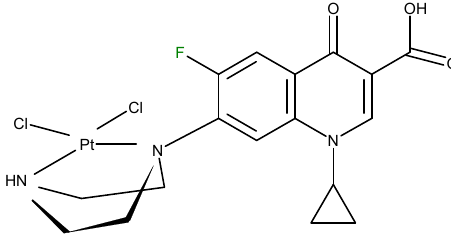
(L)] (adapted from 2